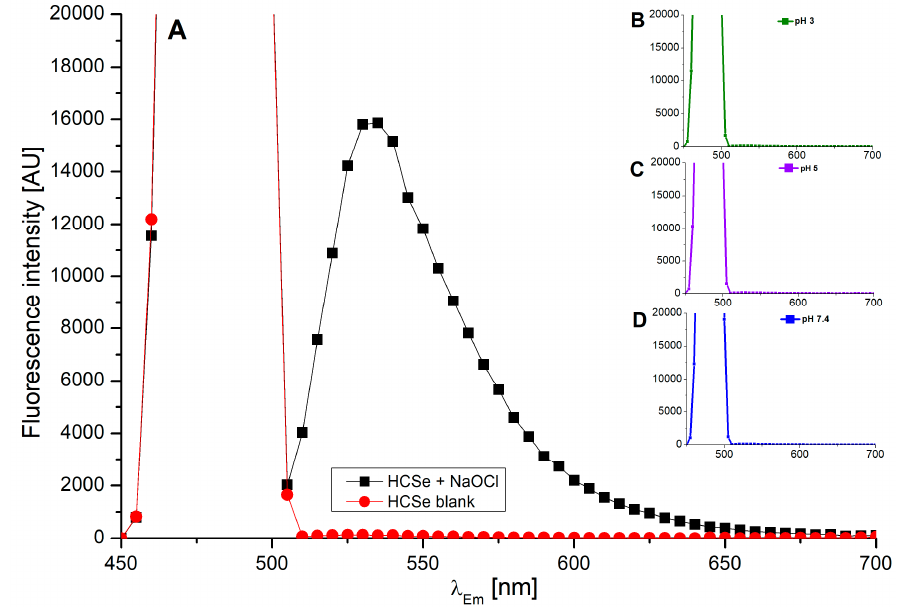
Figure 6. ( A ) Fluorescence intensity of 125 μ M of HCSe probe in the presence of 150 μ M of NaOCl at pH 5, 25 °C. Insets ( B – D ) Fluorescence of 150 μ M of probe 2 under the influence of 150 μ M of NaOCl pH 5, 25 ◦ C. Insets ( B – D ) Fluorescence of 150 µ M of probe 2 under the influence of 150 µ M of NaOCl and in the presence of 125 μ M of HCSe probe at pH 3, 5, and 7.4 ( λ Ex 480 nm) at 25 °C. and in the presence of 125 µ M of HCSe probe at pH 3, 5, and 7.4 ( λ Ex 480 nm) at 25 ◦